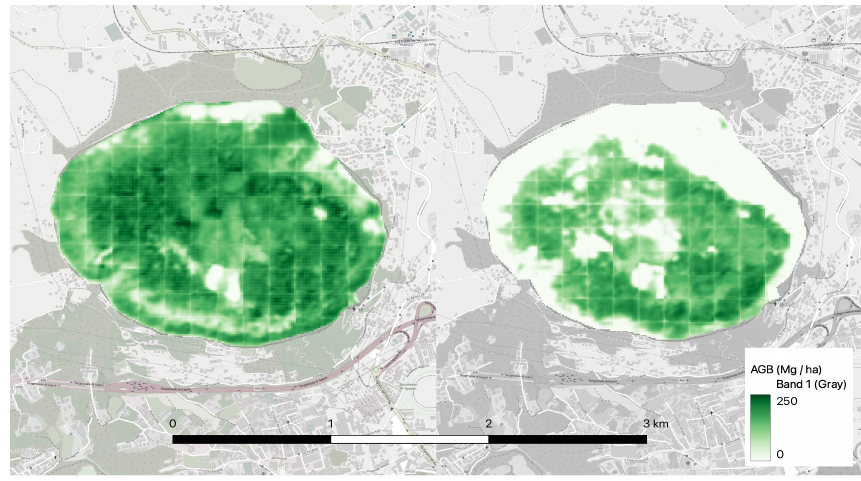
Figure 7. On the left is the predicted above-ground biomass raster of the Astroni nature reserve before the July 2017 fire; on the right is the predicted above-ground biomass raster after a major fire event for the same